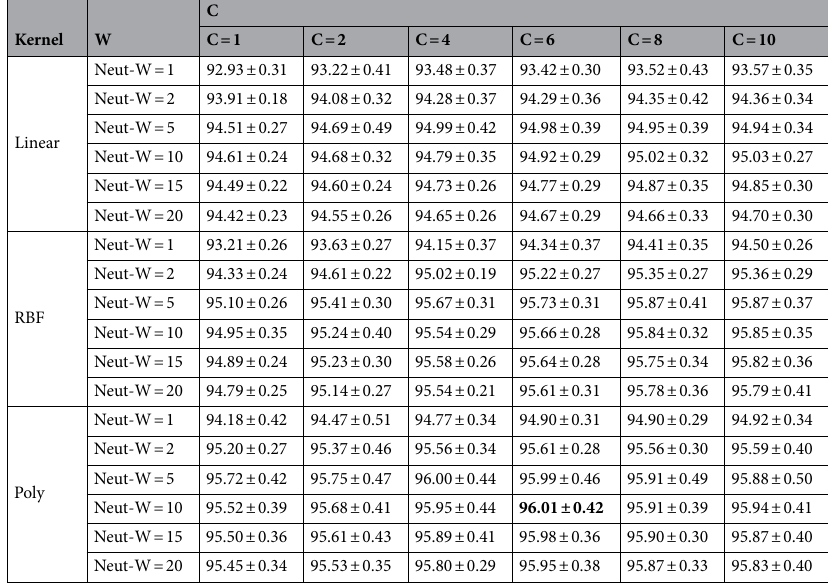
Table 2. The accuracy for fivefold cross validation on the Raabin-WBC in order to find the optimal hyperparameters; RBF (radial basis function), Poly (polynomial with degree 3), C (regularization parameter), Neut-W (neutrophil-weight). The results shows that the SVM model with polynomial kernel, C = 6, and neutrophil-weight = 10 provides the best accuracy. Bold values Illustrate the best-obtained